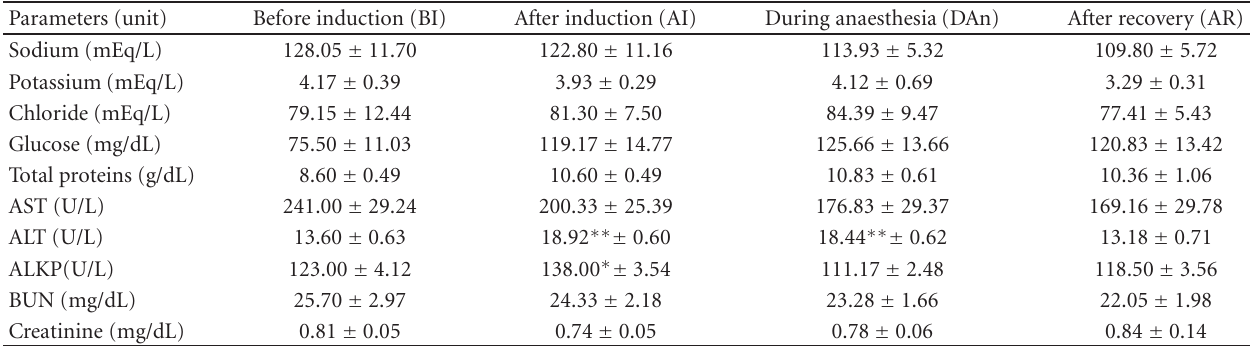
Figure 1: Electrocardiogram of a Spiti pony following xylazine-butorphanol-guaifenesin-ketamine anesthesia showing di ff erent wave changes. Table 5: Biochemical e ff ects following Xylazine-butorphanol-Guaifenesin-Ketamine anaesthesia in Spiti ponies ( n = 6). Parameters (unit) Before induction (BI) After induction (AI) During anaesthesia (DAn) After recovery